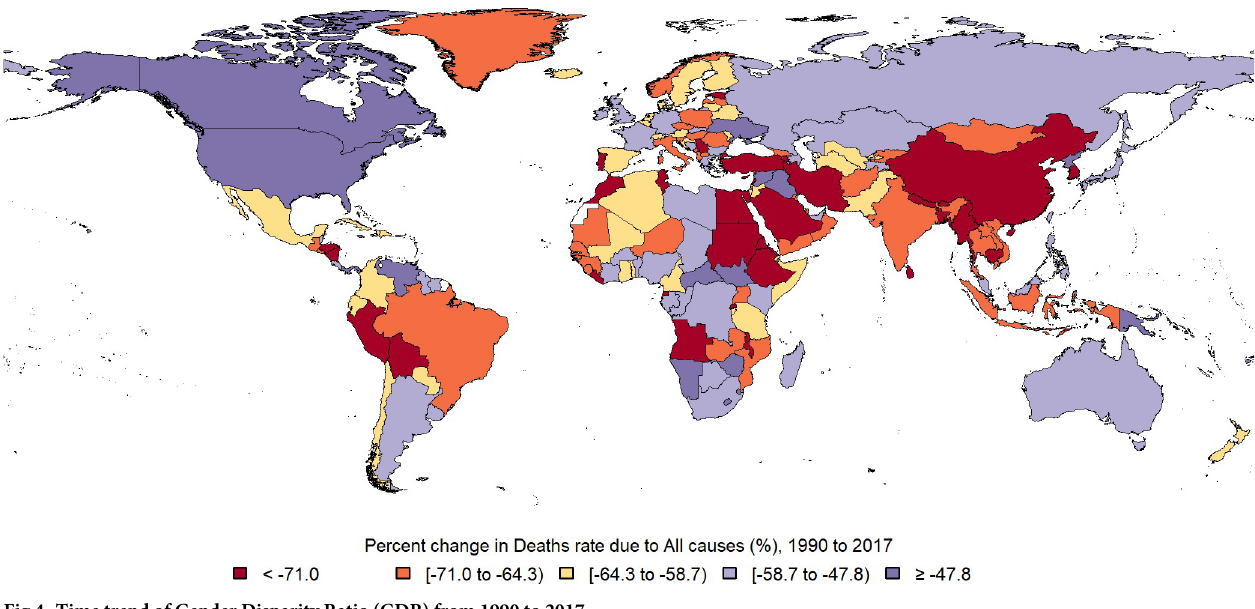
Fig 4. Time trend of Gender Disparity Ratio (GDR) from 1990 to